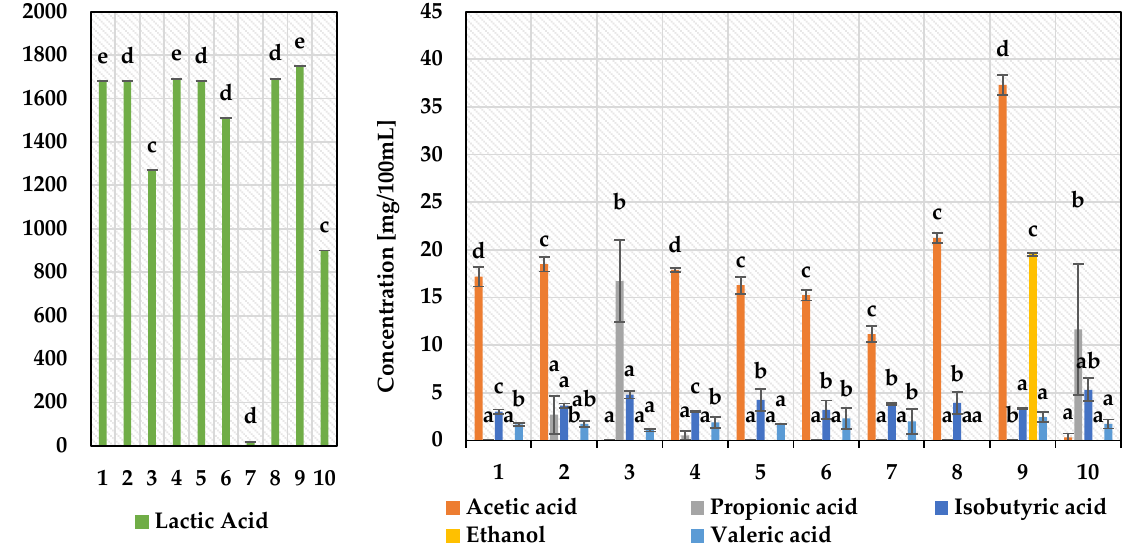
Figure 2. Fermentation by-products of 10 most active lactic acid bacteria strains cultivated on MRS medium. 1 —Lactobacillus acidophilus Ł OCK938; 2 —Lactobacillus acidophilus Ł OCK927; 3 — Lactobacillus acidophilus Ł OCK932; 4 —Lactobacillus acidophilus Ł OCK934; 5 —Lactiplantibacillus plantarum Ł OCK861; 6 —Levilactobacillus brevis 0984; 7 —Lactiplantibacillus plantarum 0991; 8— Lactiplantibacillus plantarum KB2 LAB 03; 9 —Lactiplantibacillus plantarum BPC2; 10 — Lactiplantibacillus pentosus 03(2)118A LAB; a–e—results with different letters within the sample are